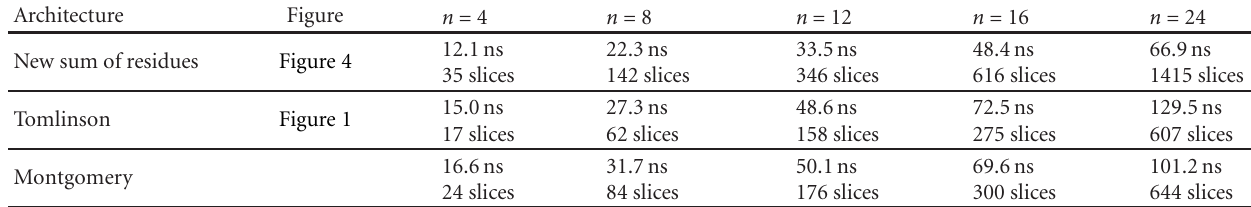
Table 1: Latency and space overhead of three interleaved modular